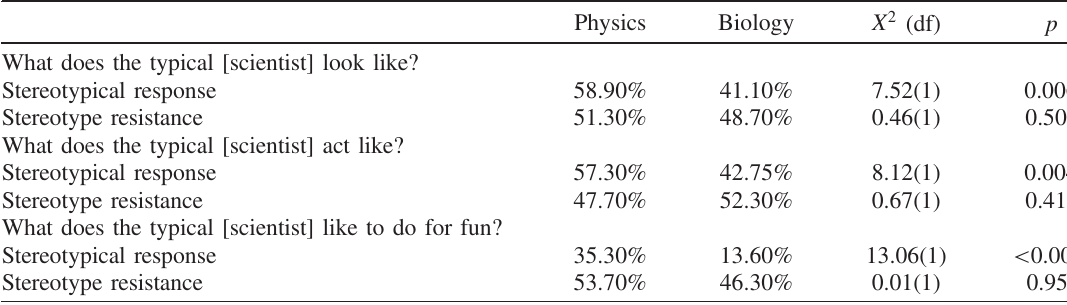
TABLE V. Frequency analyses for spontaneous stereotypes from open-ended items, n ¼ 378